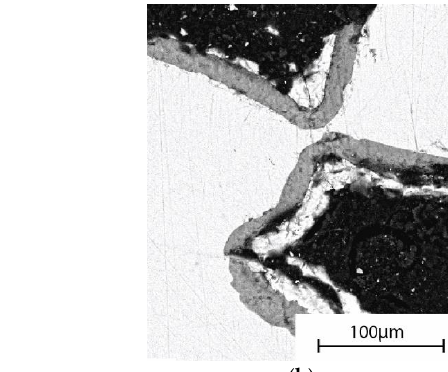
Figure 5. SEM images of cross-sections of an amorphous S53P4 scaffold after 7 days of the continuous ( a ) Tris and ( b ) SBF flow.